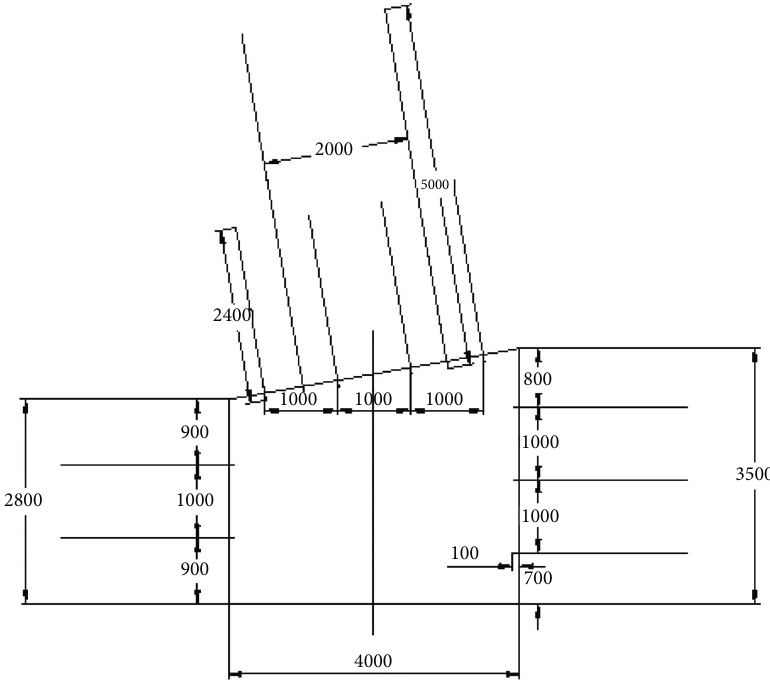
Figure 13: Roadway section support